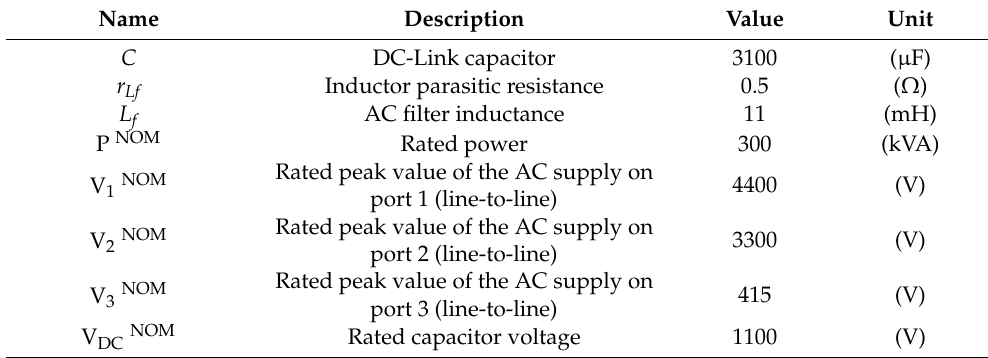
Table 3. UNIFLEX-PM converter rated parameters.